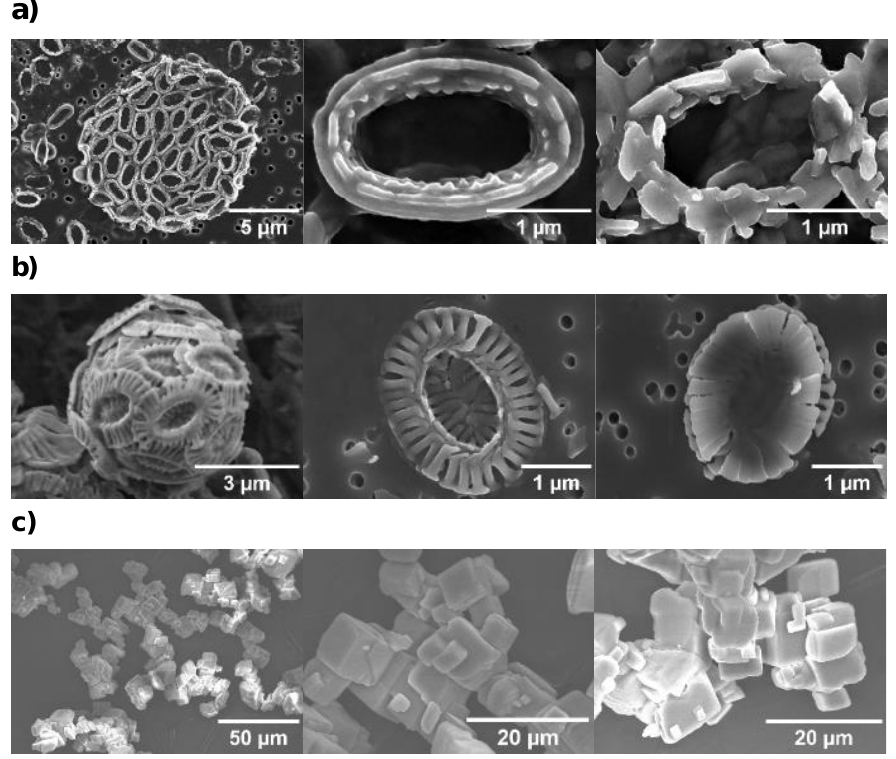
Figure 1. SEM micrographs of the fillers: ( a ) C. pseudoroscoffensis (CP), ( b ) E. huxleyi (EHUX), and ( c ) commercial CaCO 3 .